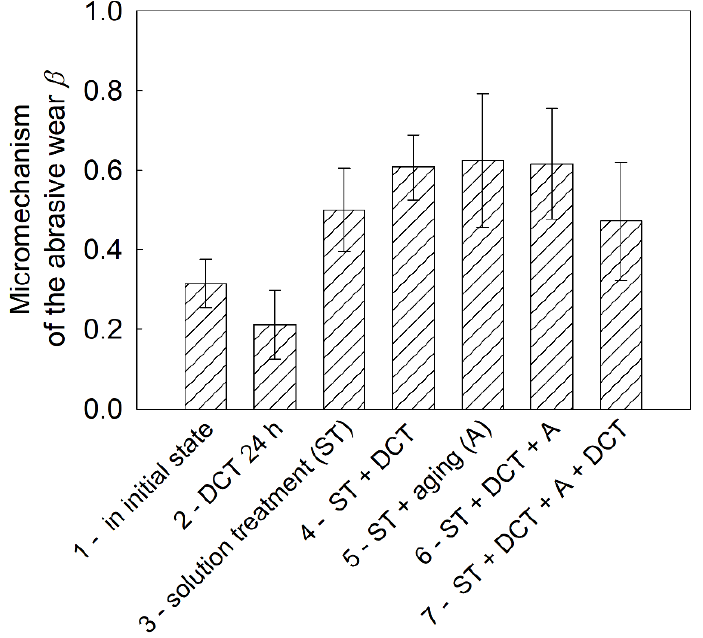
Figure 8. Changes in the wear micromechanism of the Mg-Y-Nd alloy in the initial state and after different heat treatment variants in combination with DCT.